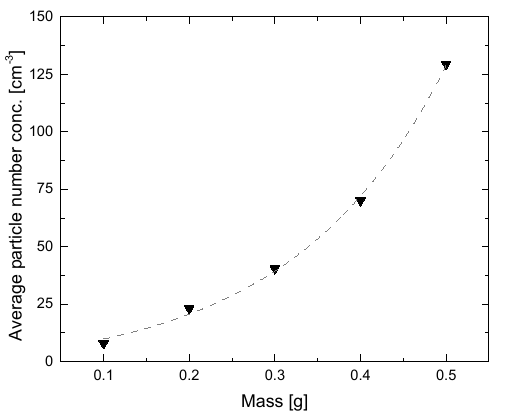
Figure 7. Particle number concentration generated as a function of Arizona Test Dust mass in the fluidized bed (triangles) with a fitted exponential curve (dashed line).